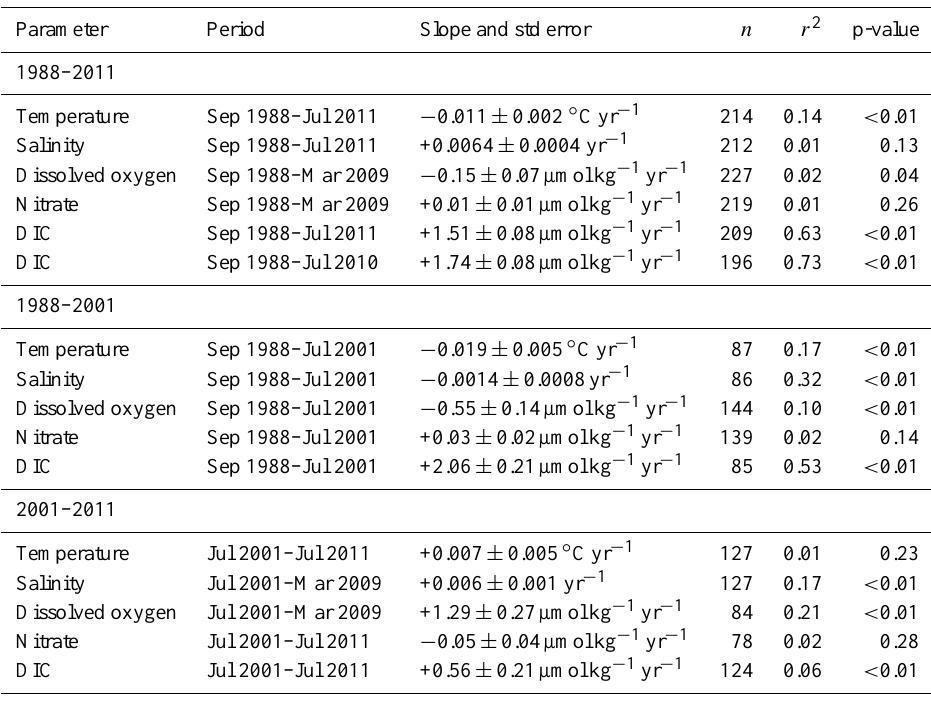
Table 2. Long-term trends of STMW hydrography and seawater carbonate chemistry with regression statistics (slope and error, n , r 2